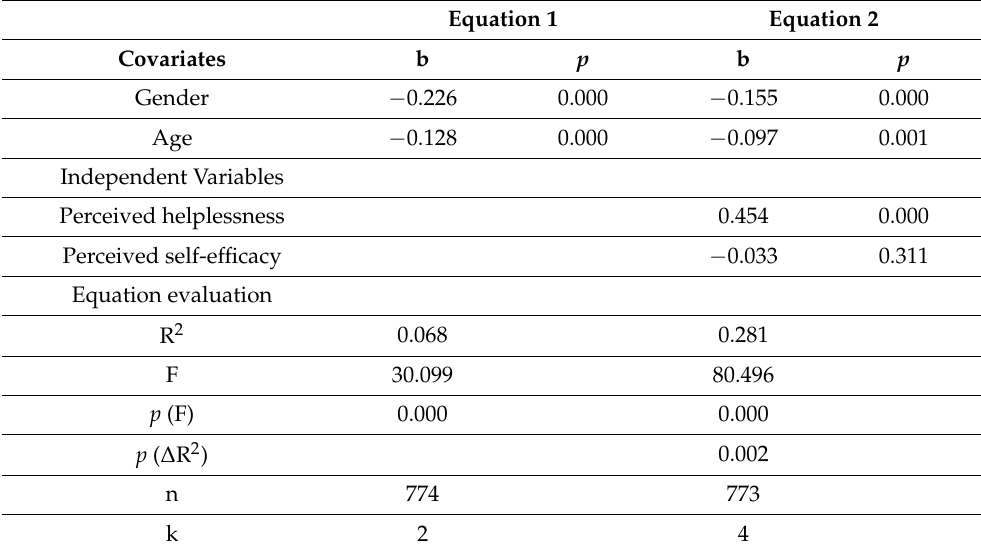
Table 8. Findings of the regression analysis for psychosomatic complaints.